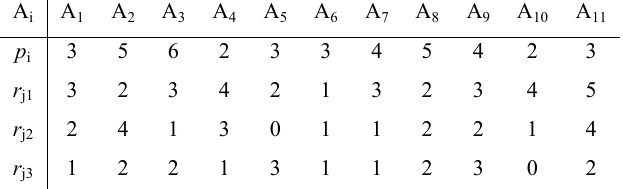
Table 2 . A project with 11 real activities and 3 resources .